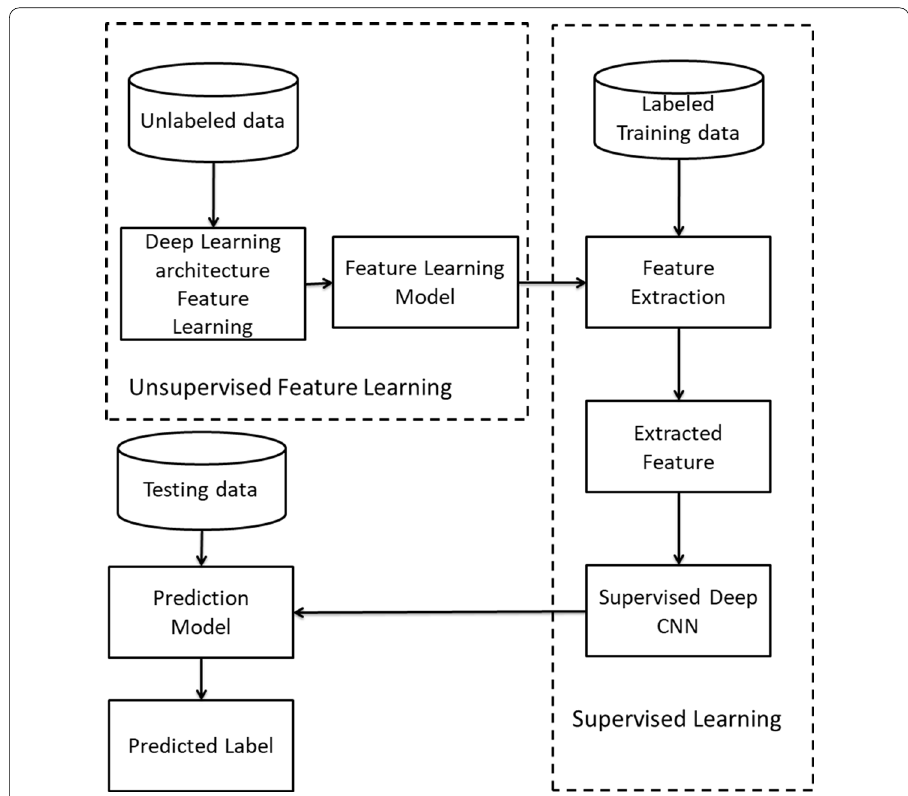
Fig. 1 Development and evaluation feature learning